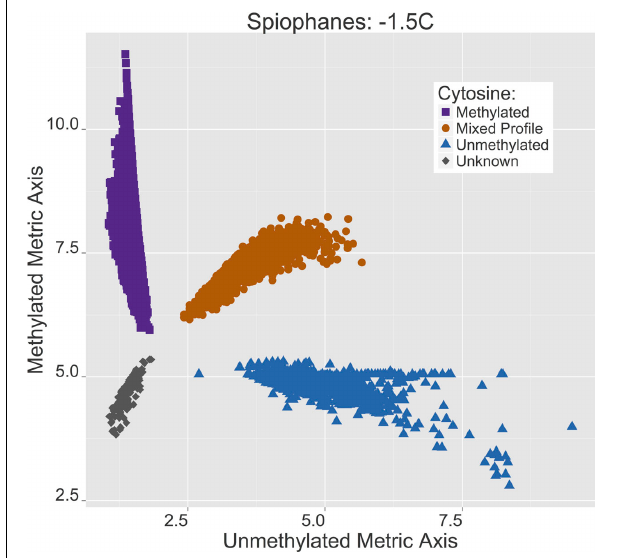
FIGURE 3 | Spiophanes tcherniai methylation score profile for the − 1.5 ◦ C worms. Each point represents a single CpG site that has been scored for a proportional representation of methylated and non-methylated copies in these samples, with these two variables plotted on each axis. Points are divided into four groups: purple squares = methylated sites, brown circles = mixed methylation sites, blue triangles = unmethylated sites, gray diamonds = unknown or unresolved sites.